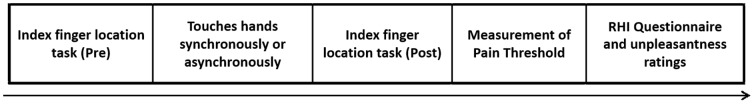
Experimental procedure.The experiment consisted of 4 sequences of experimental steps for each of the 8 conditions presented by the rubber hands. Each sequence was designed to include an index finger location task, pain threshold measurement, a rubber hand illusion questionnaire, and unpleasantness rating.